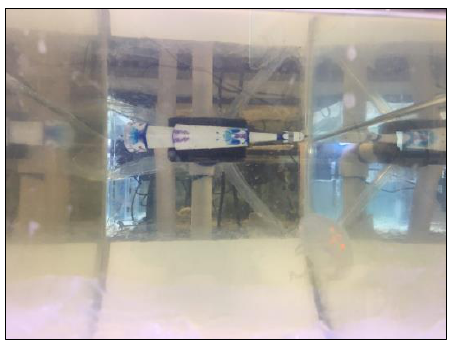
Figure 7. The correlation of the average jelly pulse to time shown by days.